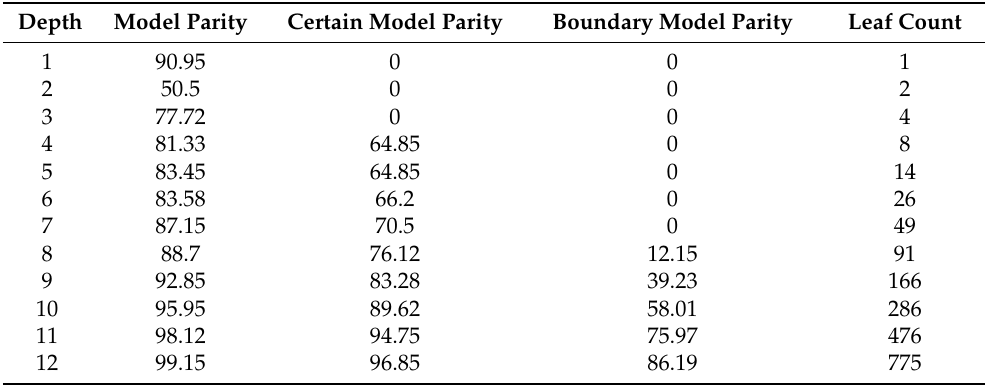
Table 3. Evaluation of the interpretable models for the circle function generated by TRE-PAN at depths ranging from 1 to 12.